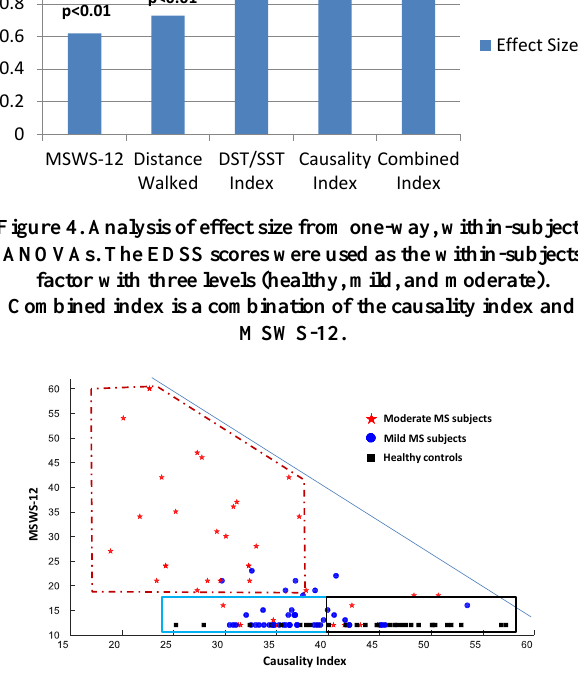
Figure 5. Causality index and MSWS-12 together provide better illustration of separability in three